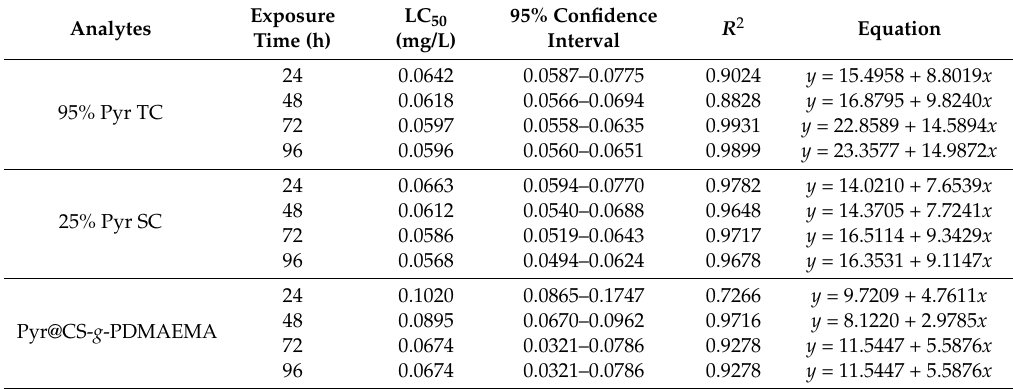
Table 3. Acute toxicity of pyraclostrobin against zebra